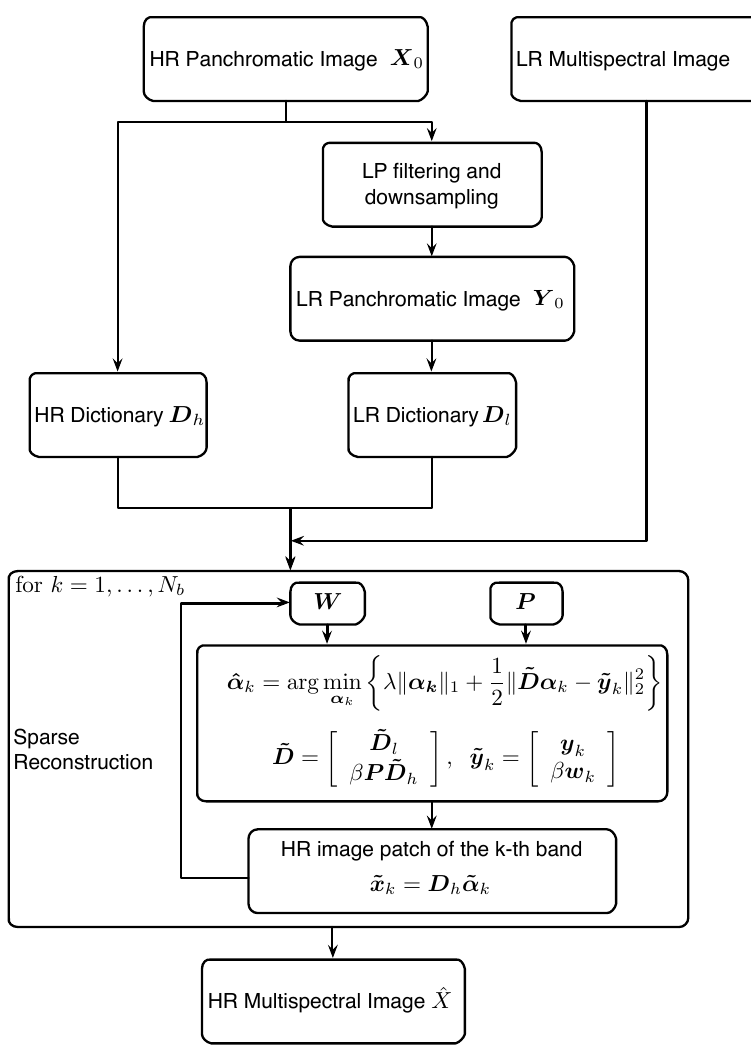
Figure 2. Block diagram of the sparse fusion of images (SparseFI) pan-sharpening method proposed in